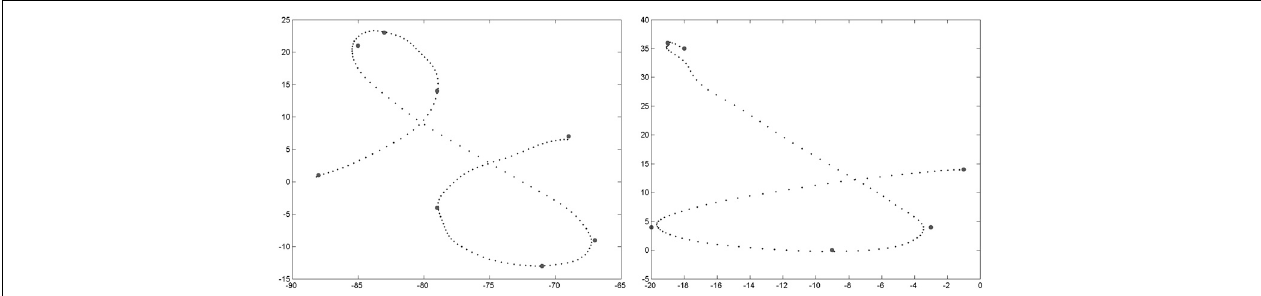
FIGURE 6 | Two allographs of the letter “f” present in the learning database. Left: the most common geometric form, where the third via-point is at the top of the first loop. Right : the less common geometric form